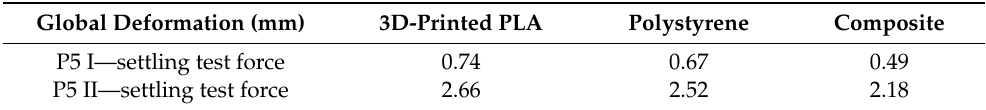
Table 5. Summary of maximum deformation results obtained by numerical simulation at settling test force for PLA, polystyrene, and composite sockets.